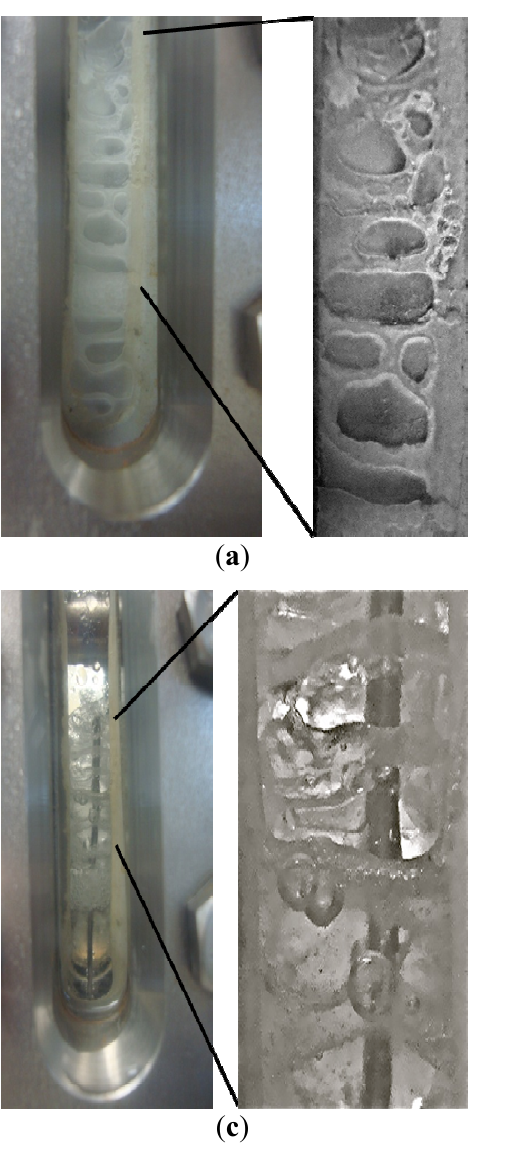
Figure 12. Time resolved visual observations of the CH formation and during dissociation for Run 5 at: ( a ) 460 psig, − 1.05 °C; ( b ) 564 psig, 1.24 °C; ( c ) 635 psig, 2.44 °C; ( d ) 848 psig, 10.25 °C. These P/T conditions correspond